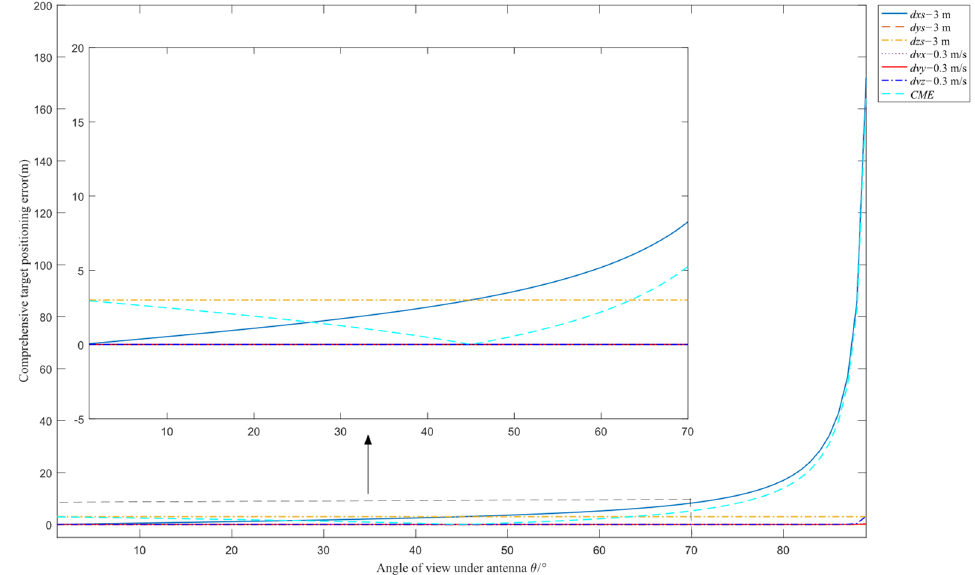
Figure 5. Influence curve of the Angle of view θ under antenna on target positioning error.